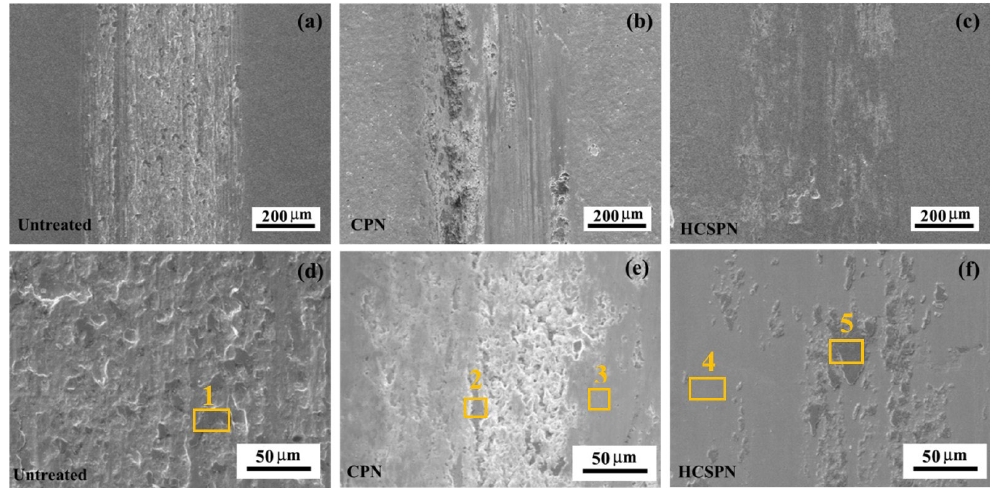
Figure 10. SEM images on the worn surface of the untreated (a and d), CPN (b and e), and HCSPN samples (c and